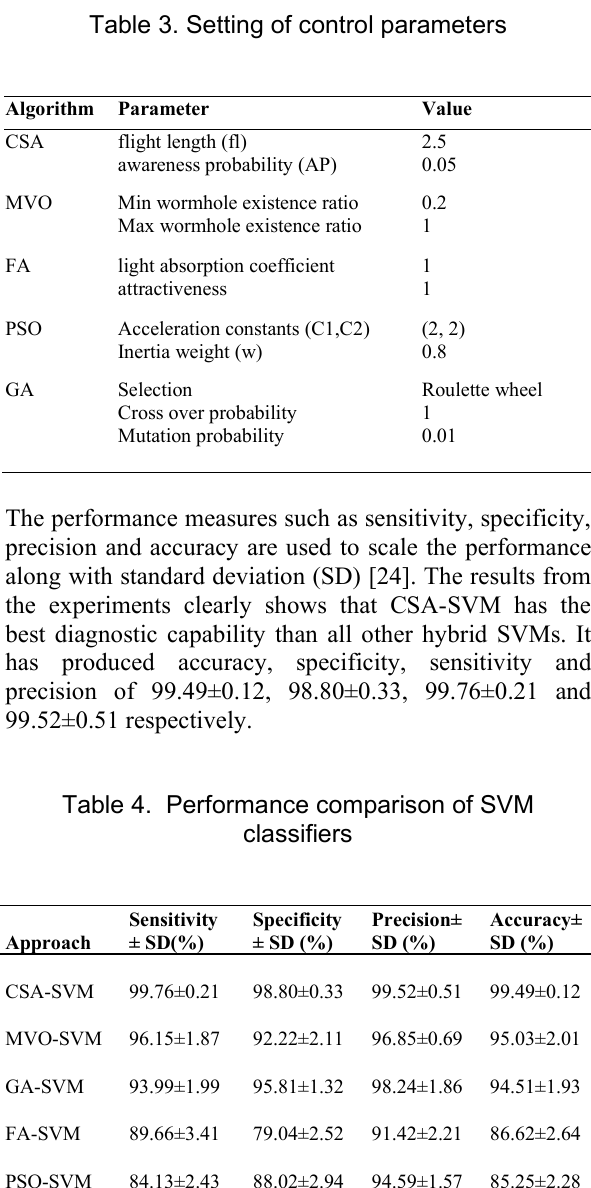
Table 3. Setting of control parameters